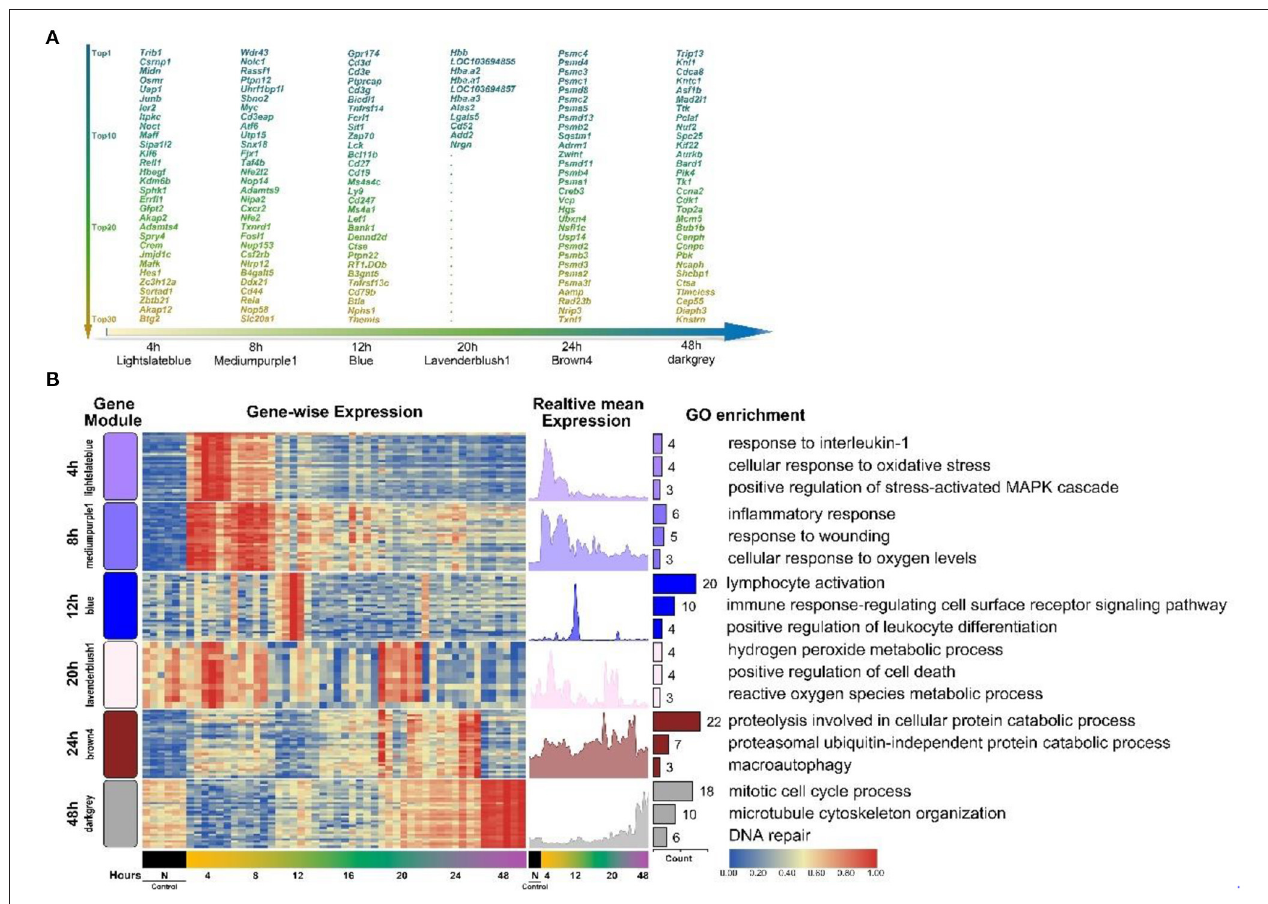
FIGURE 3 | The top high-connectivity hub genes in each HCr module identified using WGCNA analysis. (A) The top 30 high-connectivity genes in six time-point-related HCr modules listed by degree of connectivity. Different colors represent the different degrees of connectivity in each module (161 genes in total). Only 11 genes were screened in the 20h module. (B) Clustered heat map of the distribution of the 161 hub genes across time-point-related HCr modules (left, HCr modules are shown in different colors according to WGCNA results). The mean expression in each gene module is shown (right). Functional annotation of the genes in each cluster was performed using GO enrichment analysis. Only the top three enriched processes are shown, sorted by p